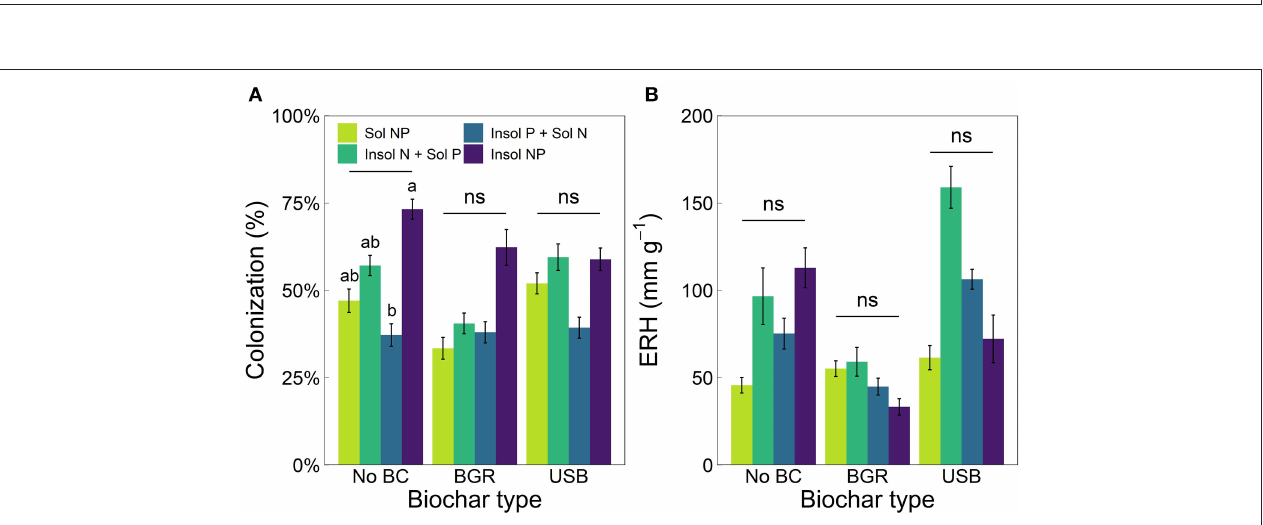
FIGURE 4 | Means ( ± SE) of (A) AMF colonization and (B) extraradical hyphal length density (ERH) for biochar (x-axis) and nutrient treatments (varied colors). Lowercase letters indicate significant differences (Tukey post-hoc tests, p < 0.05) among nutrient treatments within biochar type and “ns” indicates no significant differences. Significant differences among biochar types within nutrient treatments are displayed in Supplementary Table 2 . The x-axis label “No BC” stands for No Biochar treatments.